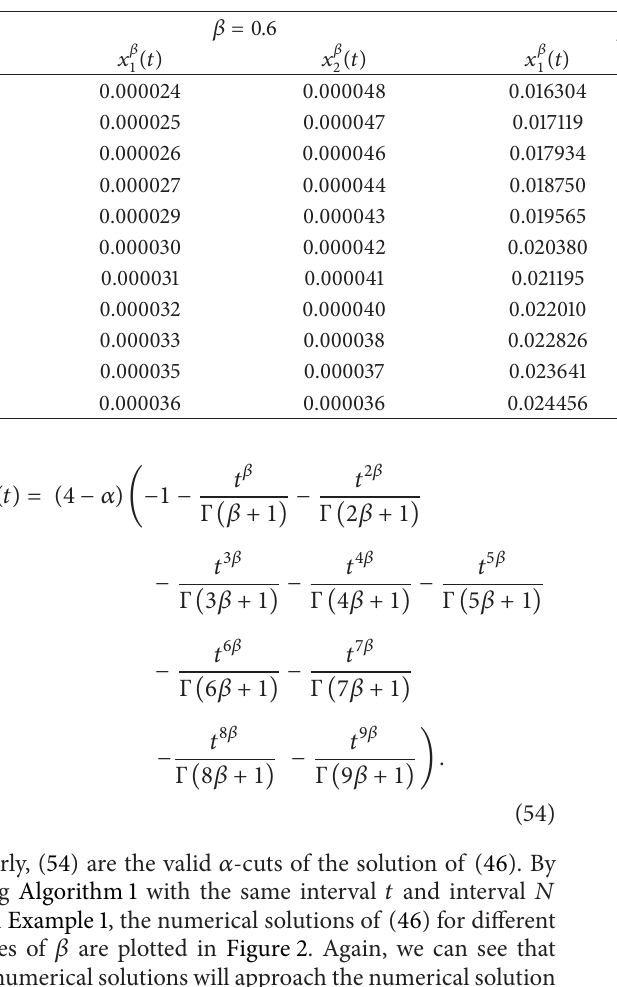
Table 2: Numerical solutions of Example 2 with different values of 𝛽 .